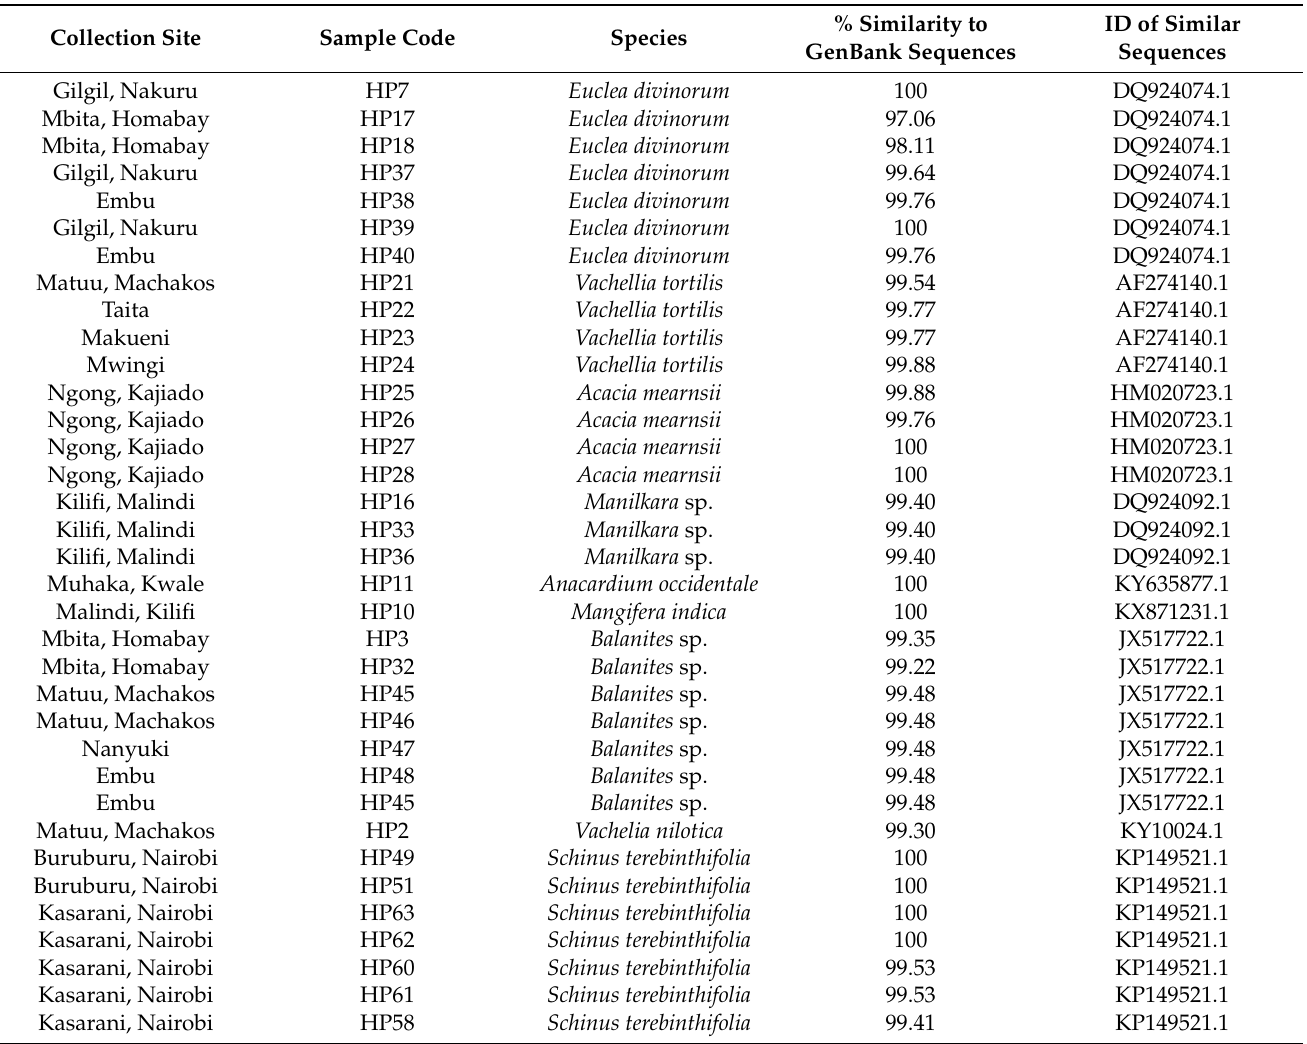
Table 7. Identities of edible saturniid host plants based on similarities with sequences from